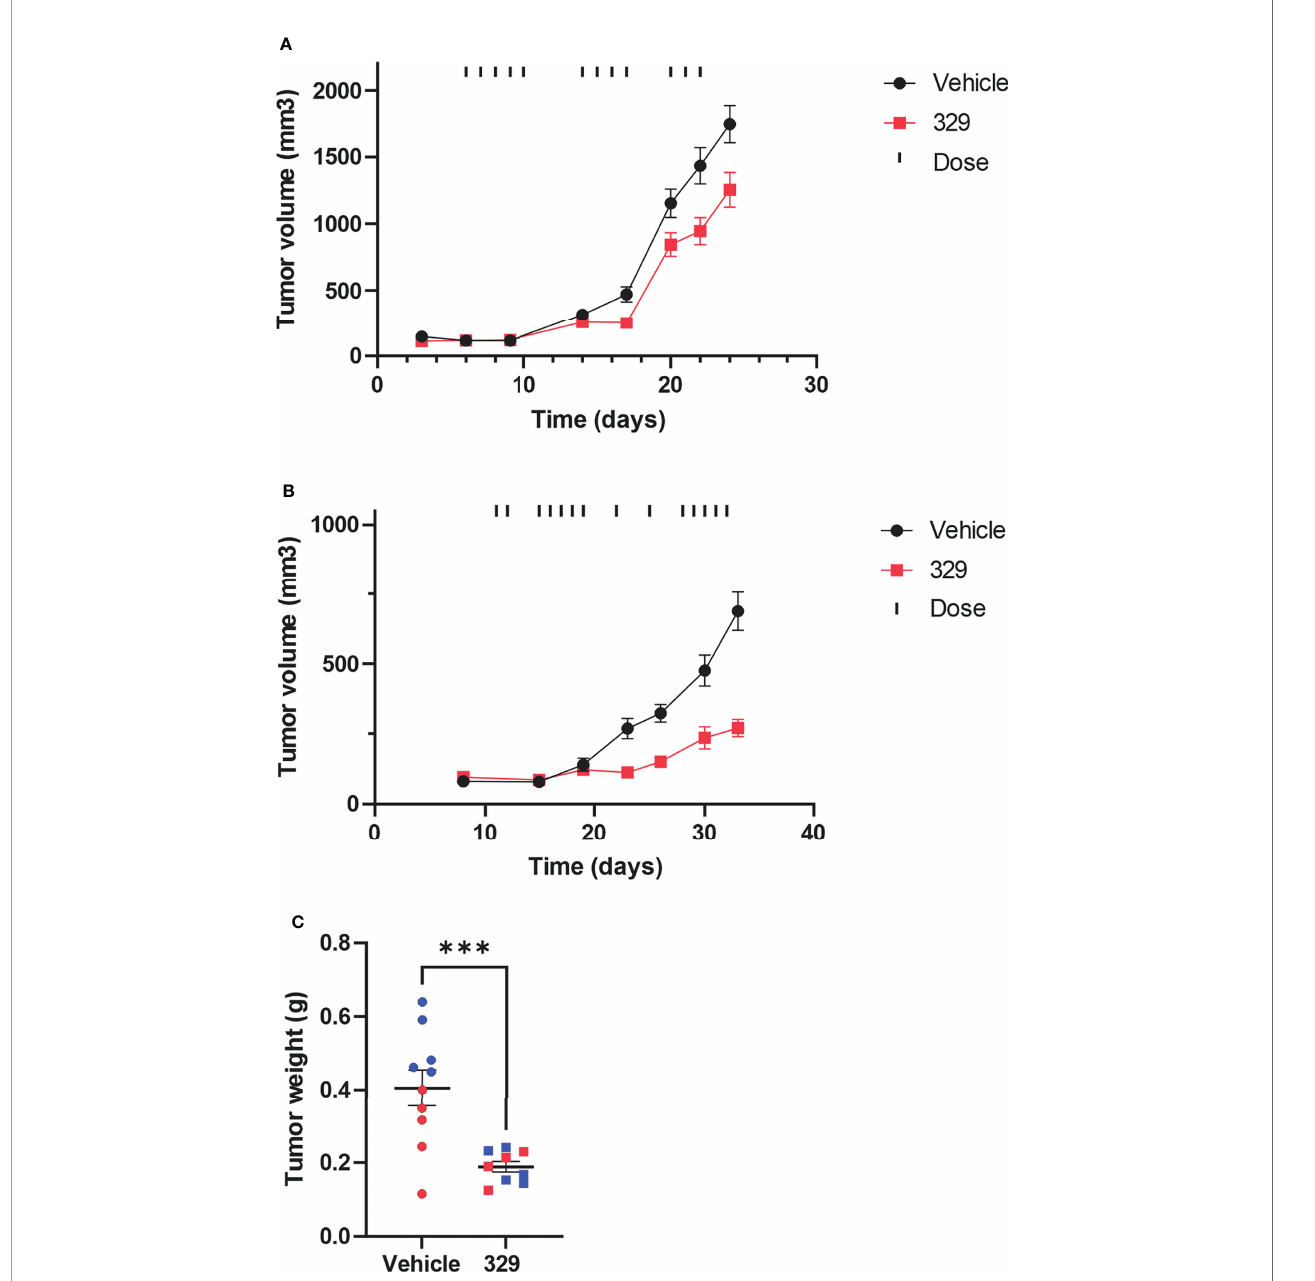
FIGURE 8 | In vivo analysis of anticancer activity of 329 . (A) Anticancer activity was assessed in human H460 NCSLC tumor xenografts in NOD/SCID mice. Mice were implanted subcutaneously on day 1 with H460 NSCLC cells, tumors were measured by calipers, and mice assigned randomly to treatment arms. Treatment with 329 was initialized at day 6 and administered via intraperitoneal injection (IP) once daily (20 mg/kg), as indicated ( | ). Tumor volumes were completed with caliper measurement biweekly. (B) A549 cells were implanted subcutaneously, mice were randomized, and treatment with 329 was initiated at day 11 via IP (40 mg/kg) and treated once daily as indicated (|). (C) Tumor weight from A549 cells was determined on day 32. Statistically signi fi cance differences from vehicle-treated tumors are indicated by the asterisk *p < 0.05; ***p <